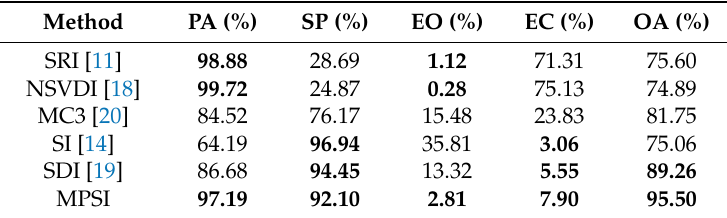
Table 3. Shadow detection accuracy data for test image C in Figure